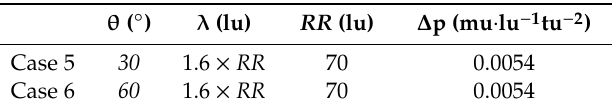
Table 2. Parameters of single bubble in Cases 5–6.